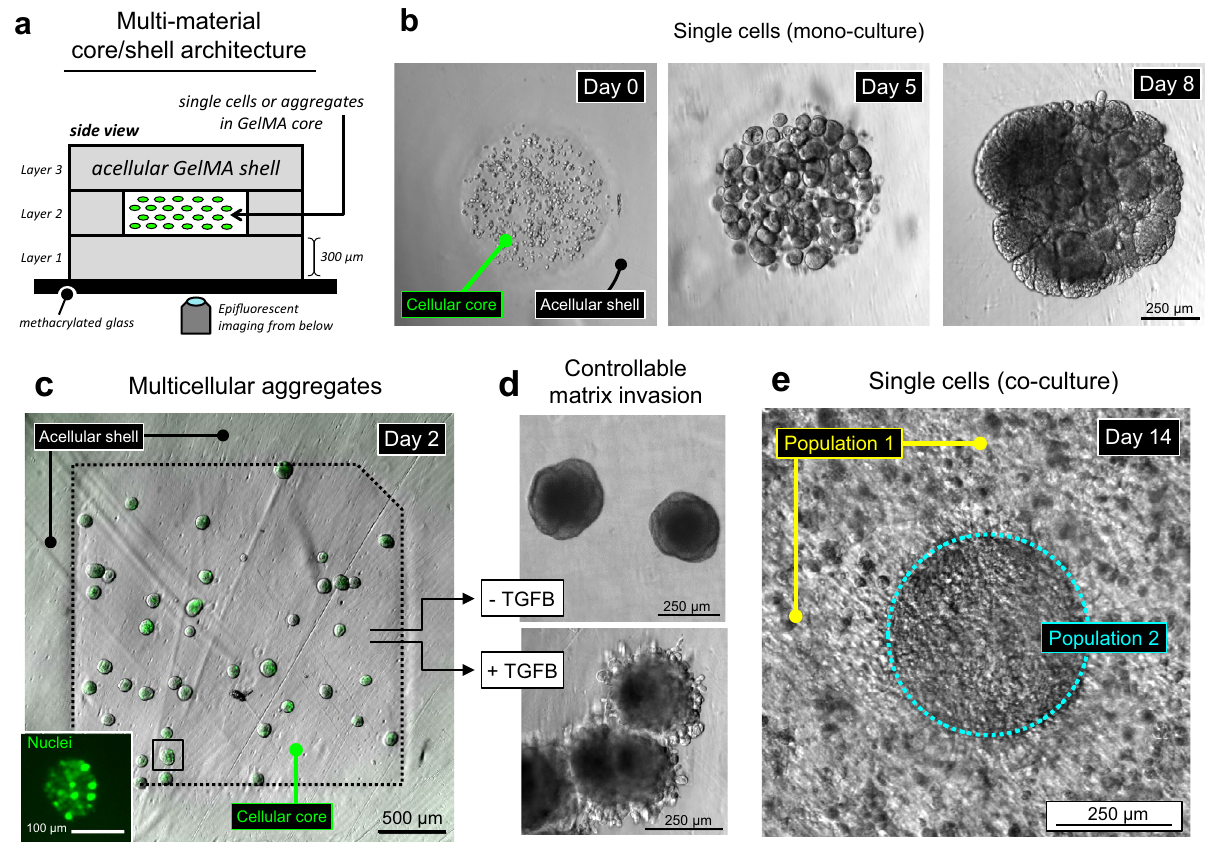
Figure 5. Growth and functional response of bioprinted cells and multicellular aggregates. ( a ) Schematized core/shell architecture of multi-material bioprinted constructs (5 wt% GelMA), viewed from the side. The surrounding a cellular shell provides a large growth volume for 3D cell migration, preventing unwanted 2D cell spreading along the gel’s exterior surfaces. ( b ) Bioprinting of single 344SQ cells within sharply defined cylindrical cores. Due to the saline rinsing step between material selections, the surrounding a cellular shell is completely free of off-target cells. Over 5 days in culture, the encapsulated cells extensively proliferated and self-assembled into spheroids, a well-known behavior of 344SQ cells in other naturally derived hydrogel materials. By day 8, spheroids further coalesced into a dense unified structure (n = 3 gels). ( c ) Direct bioprinting of pre-formed multicellular aggregates. Inset: a GFP-tagged nuclear transcription factor enables single-cell visualization. ( d ) After several days, the aggregates cultured only in growth media maintained their original spherical morphologies, while aggregates exposed to hTGF-β1 adopted invasive morphologies. This controllable invasion behavior implicates the chosen architecture and GelMA bioink as a relevant system for deeper functional studies (n = 1 gel for each condition). ( e ) An idealized model of intratumoral heterogeneity. By day 14, the separate cell populations grew to form a dense and seamless regional interface, likely suitable for longitudinal interrogation of emergent tumormosaicism (n = 4